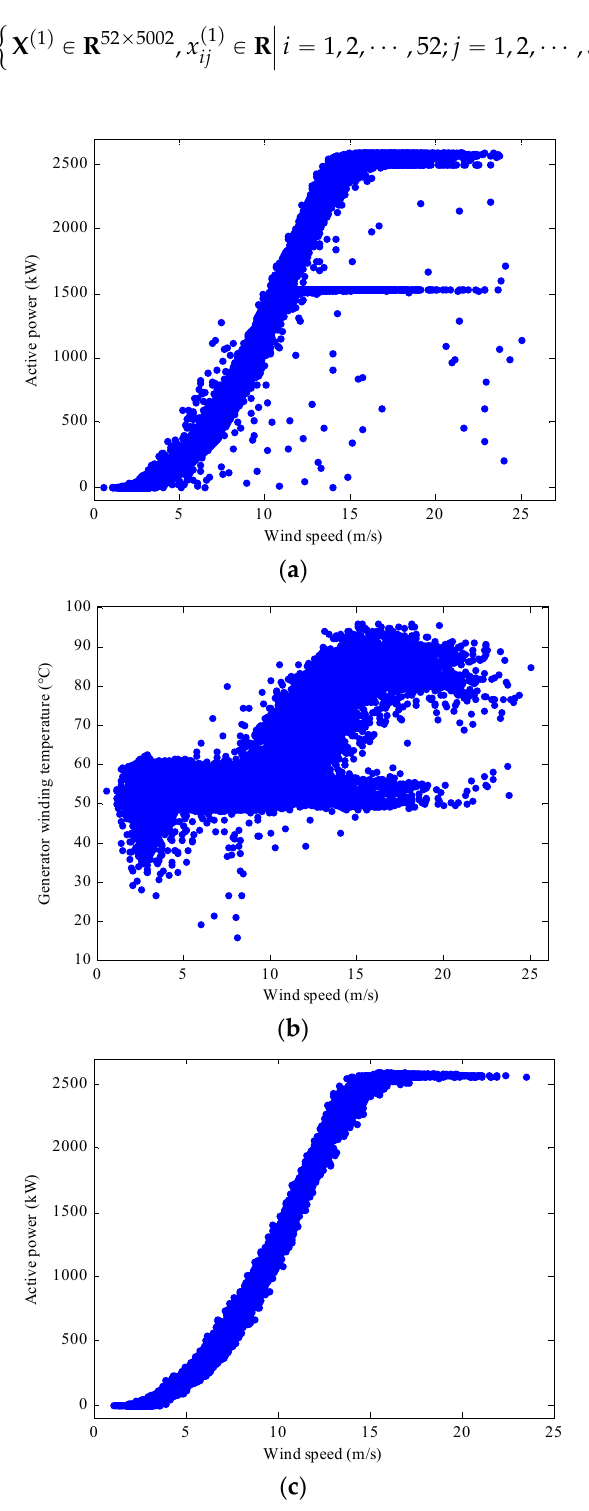
Figure 2. Scatter plots of the processed SCADA data: ( a ) Active power against wind speed; ( b ) Generator winding temperature against wind speed; ( c ) Active power output of a fault ‐ free wind turbine.